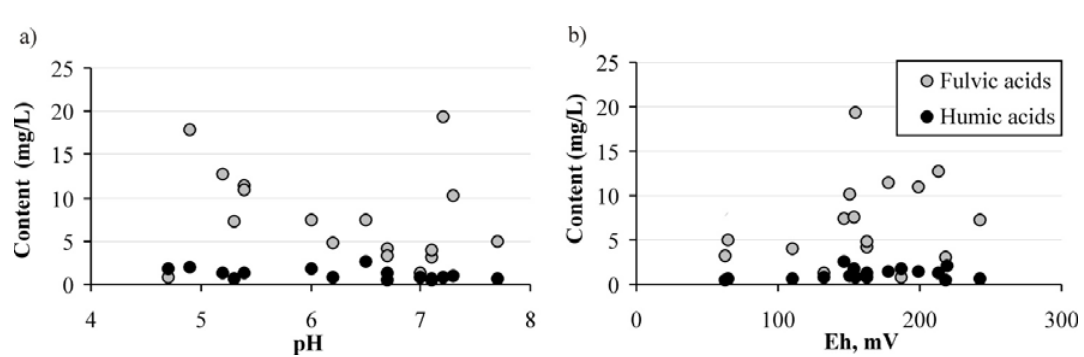
Figure 4. Relationship of organic acid content vs. pH ( a ); organic acid content vs. Eh ( b ) for same water points from the studied area